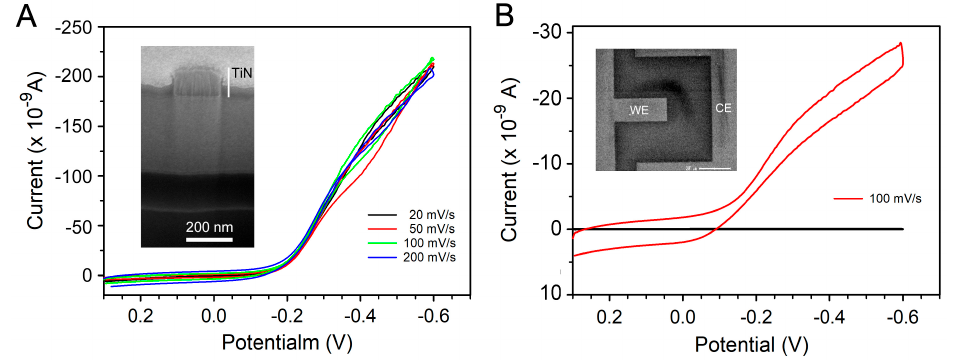
Figure 5. Cyclic voltammograms of Ru(NH 3 ) 63+ on different electrodes. ( A ) 5 mM Ru(NH 3 ) 63+ at 3D-NEA. ( B ) 5 mM Ru(NH 3 ) 63+ at the microelectrode (33.6 × 8.8 µ m 2 ). The inset in each panel is the SEM image of the corresponding microelectrode or nano-electrode. The scale bar in the inset of panel ( B ) is 20 µ m.